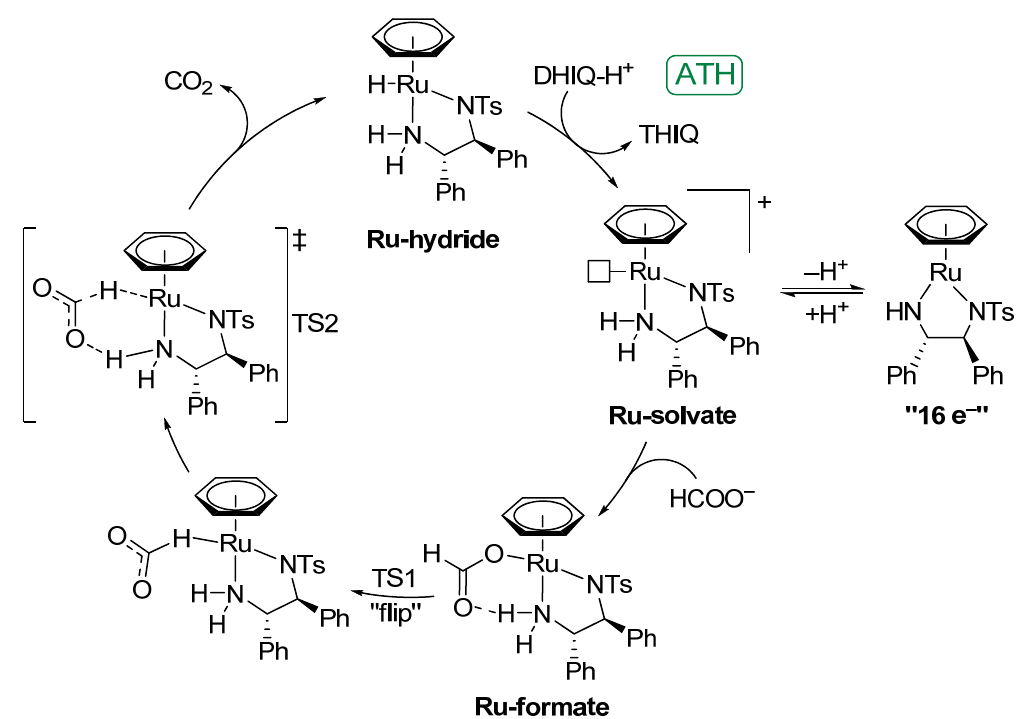
of Ru-hydride from the Ru-solvate ( i.e. , protonated 16e − complex) and formate ion.